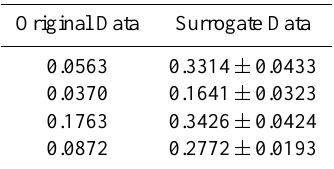
Table 1. Results of the surrogate data test for Lyapunov exponents for TEC data for the quietest days of October 2011 at Lagos station.